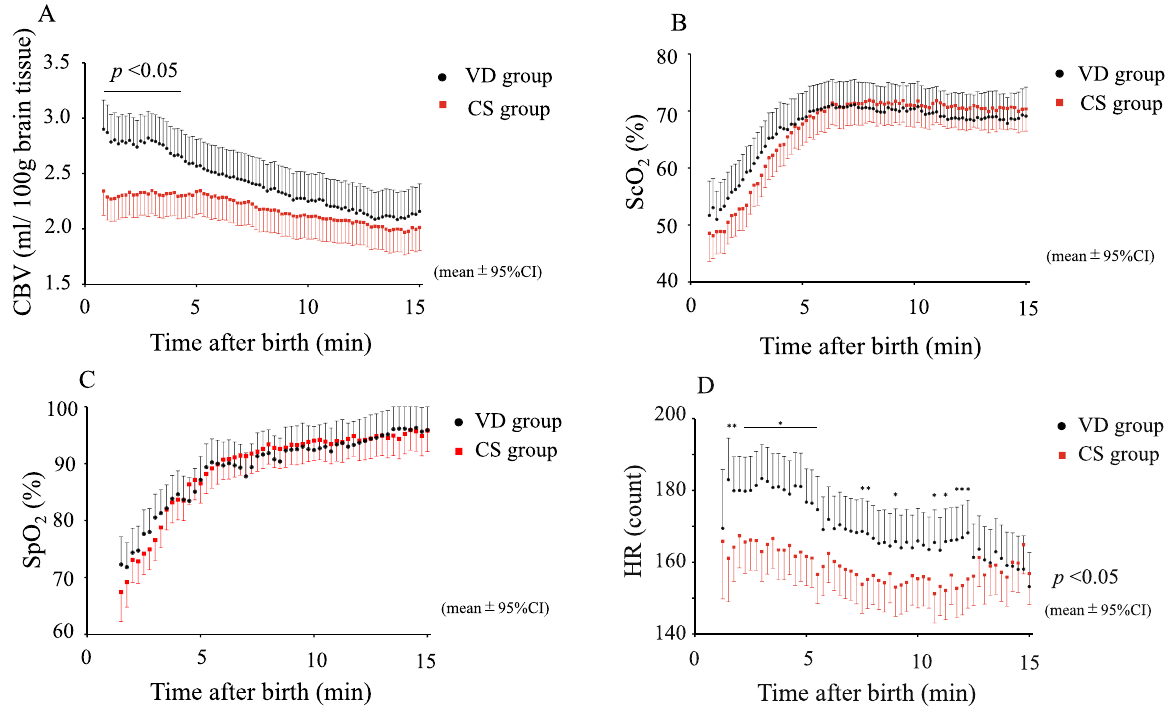
Figure 1. Time course of CBV ( A ), ScO 2 ( B ), SpO 2 ( C ), and HR ( D ) during the first 15 min after birth in healthy neonates in the VD group (black) and the elective CS group (red). The values are shown as the mean (95% confidence interval [CI] of the mean); P < 0.05, group comparisons by linear mixed model. CBV cerebral blood volume, CS caesarean section, ScO 2 cerebral haemoglobin oxygen saturation, SpO 2 arterial oxygen saturation, VD vaginal